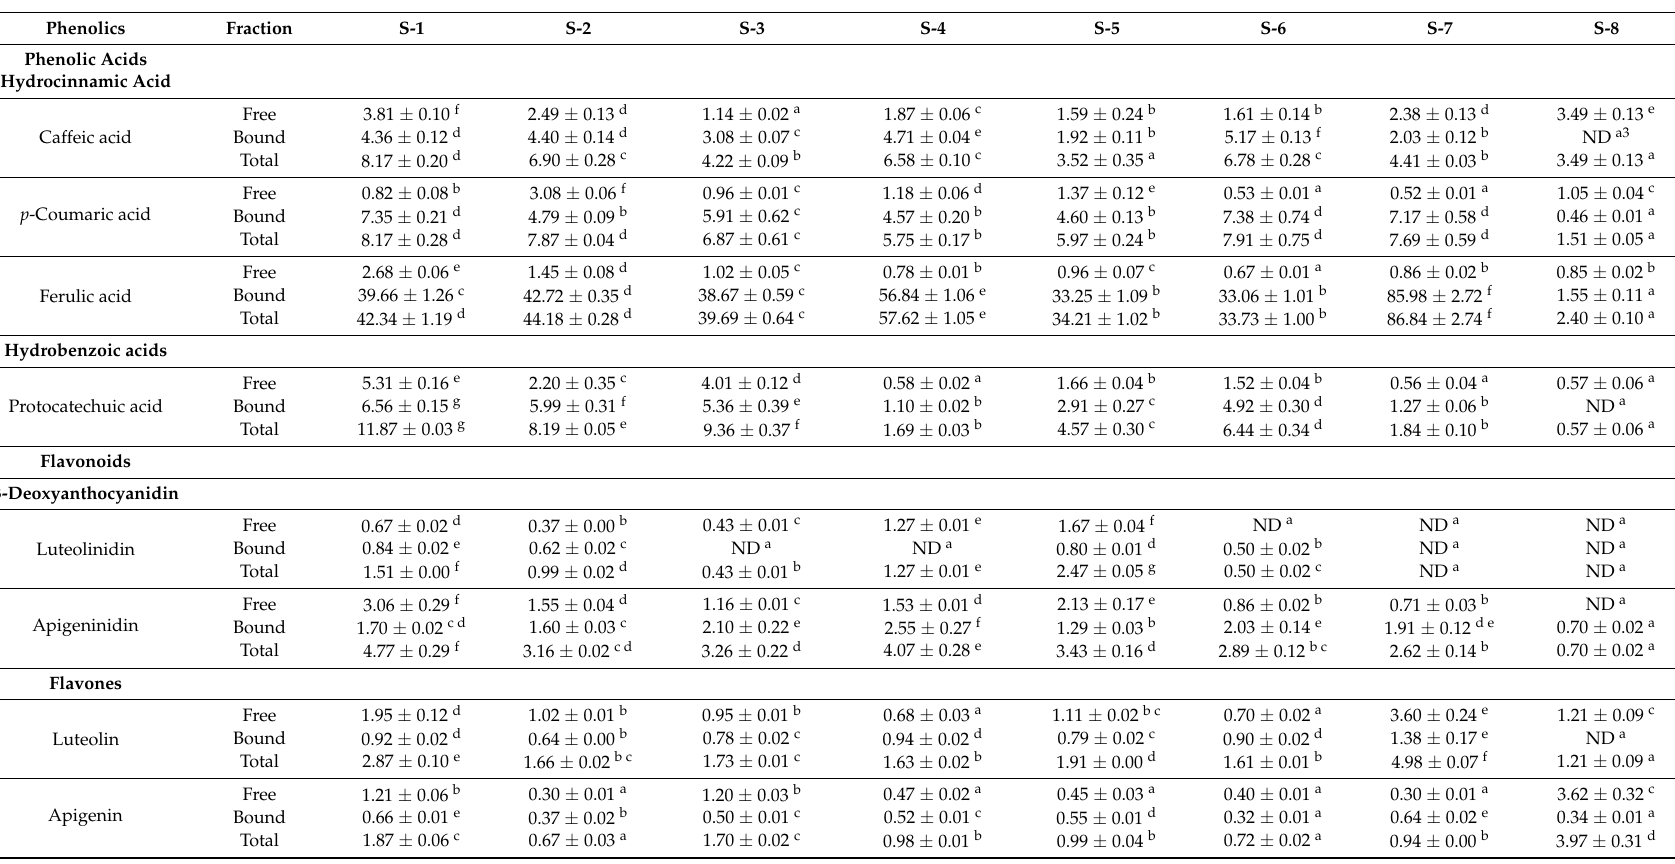
Table 3. The extractable and bound individual phenolic contents (mg/100 g grain, DW 1 ) 2 in eight varieties of sorghum